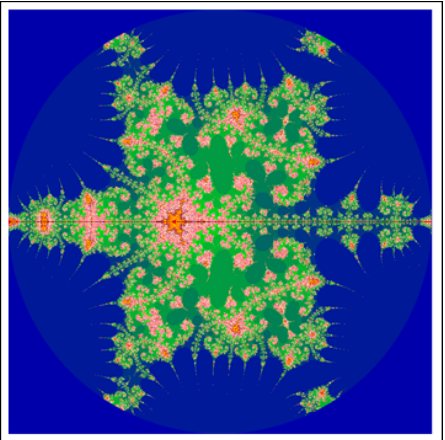
Figure 16. J-set via F-iteration for sin ( z 3 ) + 0.51 with image visual time = 62.37 s.